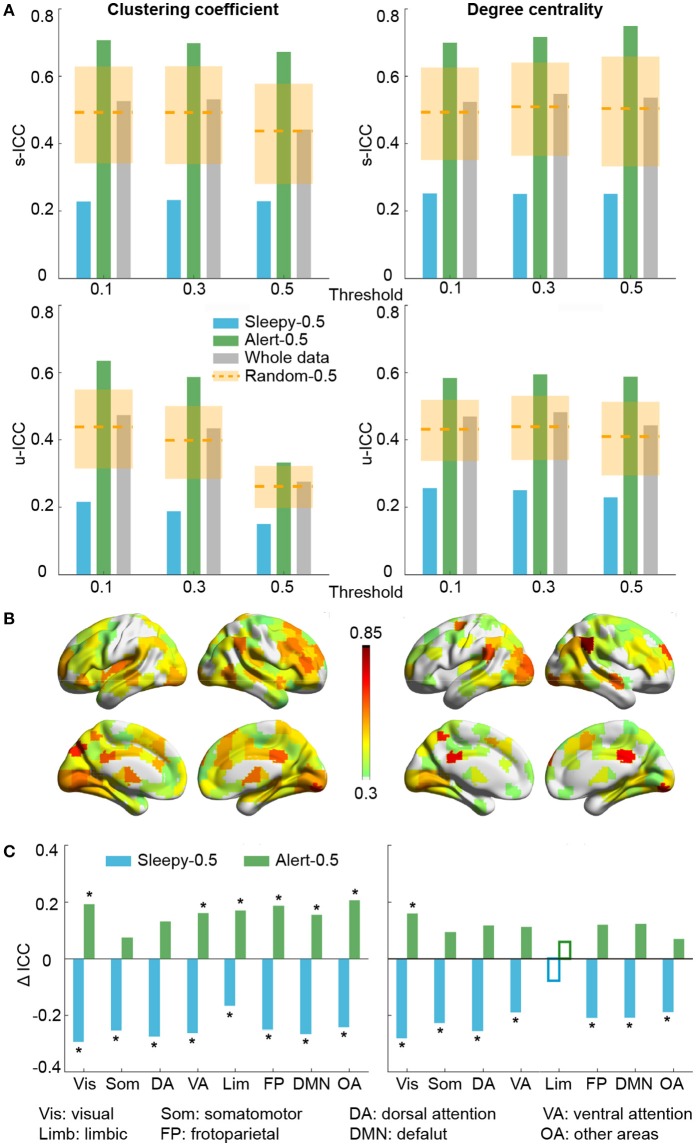
Test-retest reliability analysis using graph theoretical measures, based on RMSSD. (A) Average unit-wise (upper panel) and scan-wise (lower panel) ICCs during resting state across three thresholds (Tr = 0.1, 0.3, 0.5). Orange dashed lines indicate the average ICC values of the random-0.5 conditions, and the shaded boxes indicate their distributions—upper and lower bounds marking the 95 and 5 percentiles, respectively. Values outside the boxes are significantly different from the random conditions (one-tailed permutation test, p < 0.05). (B) Unit-wise ICC differences between sleepy-0.5 and alert-0.5 conditions (warm color: alert-0.5 > sleepy-0.5; cool color: alert-0.5 < sleepy-0.5). Differences greater than 0.3 are displayed. (C) Unit-wise ICC difference between sleepy-0.5 or alert-0.5 and the whole data at network level, which is represented using mean across ROIs within each network. Solid bars indicate significant differences compared to the random-0.5 condition (one-tailed permutation test, FDR-corrected p < 0.05). Asterisks indicate ICC changes over 30% relative to the whole data condition. Results in (B,C) were generated using Tr = 0.1.